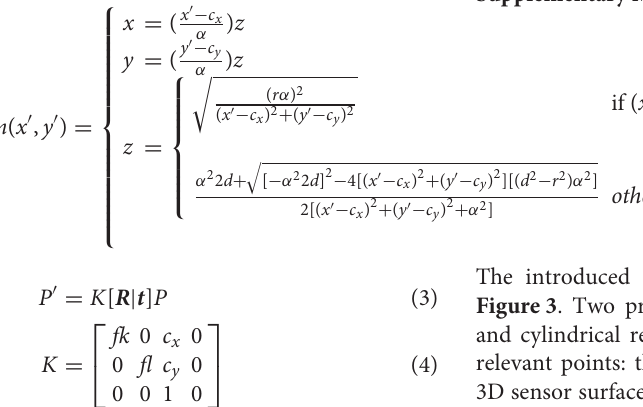
relevant points: the frame of reference origin, the point in the 3D sensor surface, and the corresponding projected point in the image